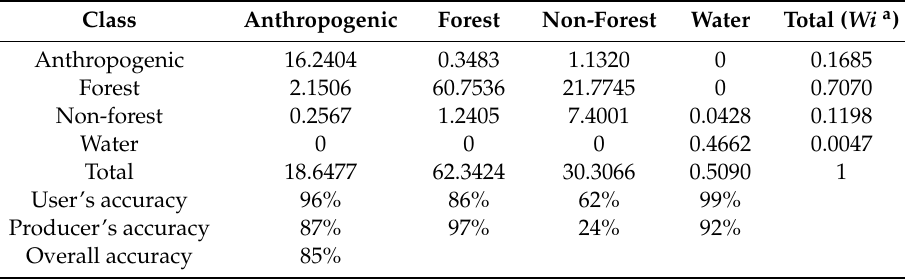
Table 1. Confusion matrix and accuracy statistics.